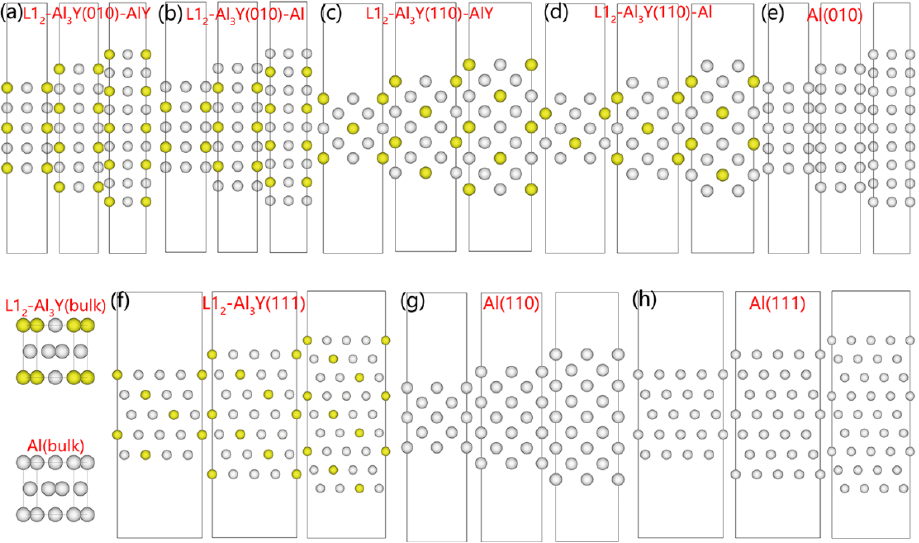
Figure 1. Slab surface models with different layer numbers of Al 3 Y ( a – f ) and Al ( g , h ), and bulk Al 3 Y and Al models Y: yellow ball; Al: white